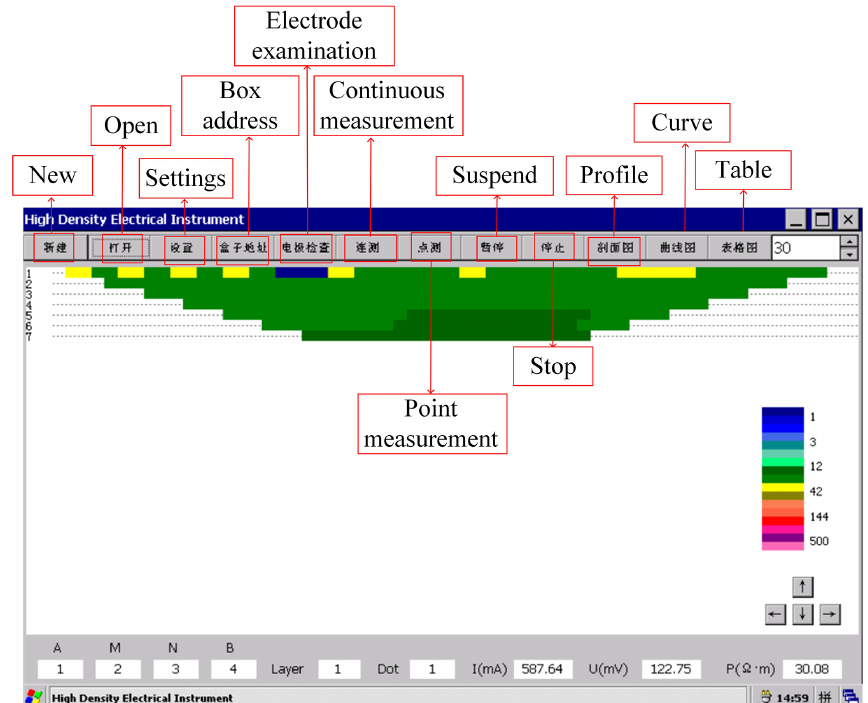
Figure 11. Real-time profile view of the test site as displayed on the electrical instrument.